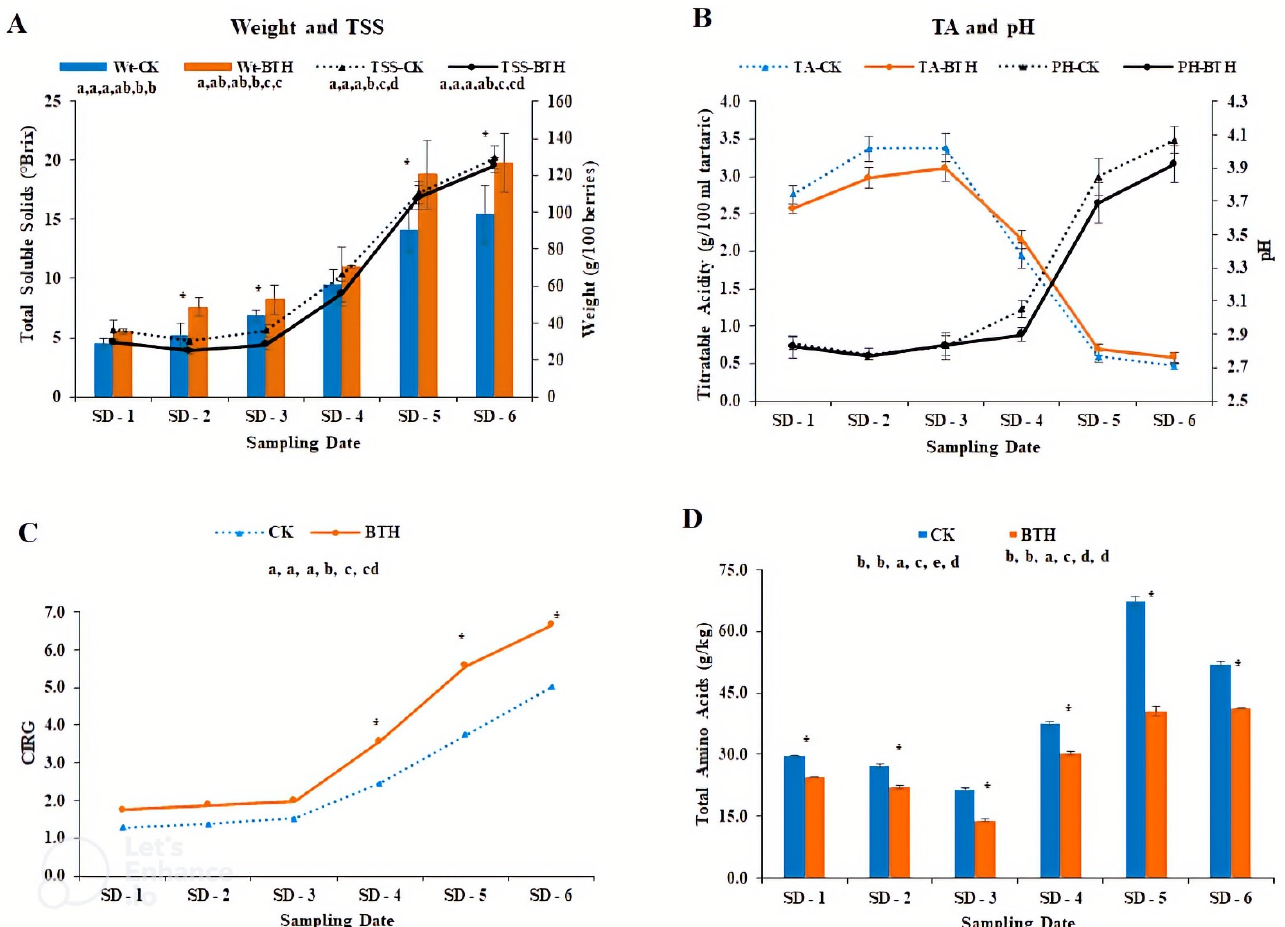
Figure 1. Physicochemical properties of untreated and treated Cabernet Gernischt cv grapes. For each sampling date, an asterisk (*) indicates a significant difference between treatments (CK and BTH) at p < 0.05 and for each parameter, different alphabets indicate differences between sampling dates at p < 0.05. CK; Control, TSS; Total Soluble Solids, TA; Titratable Acidity, CIRG; Color Index for Red Grapes, SD; Sampling date.